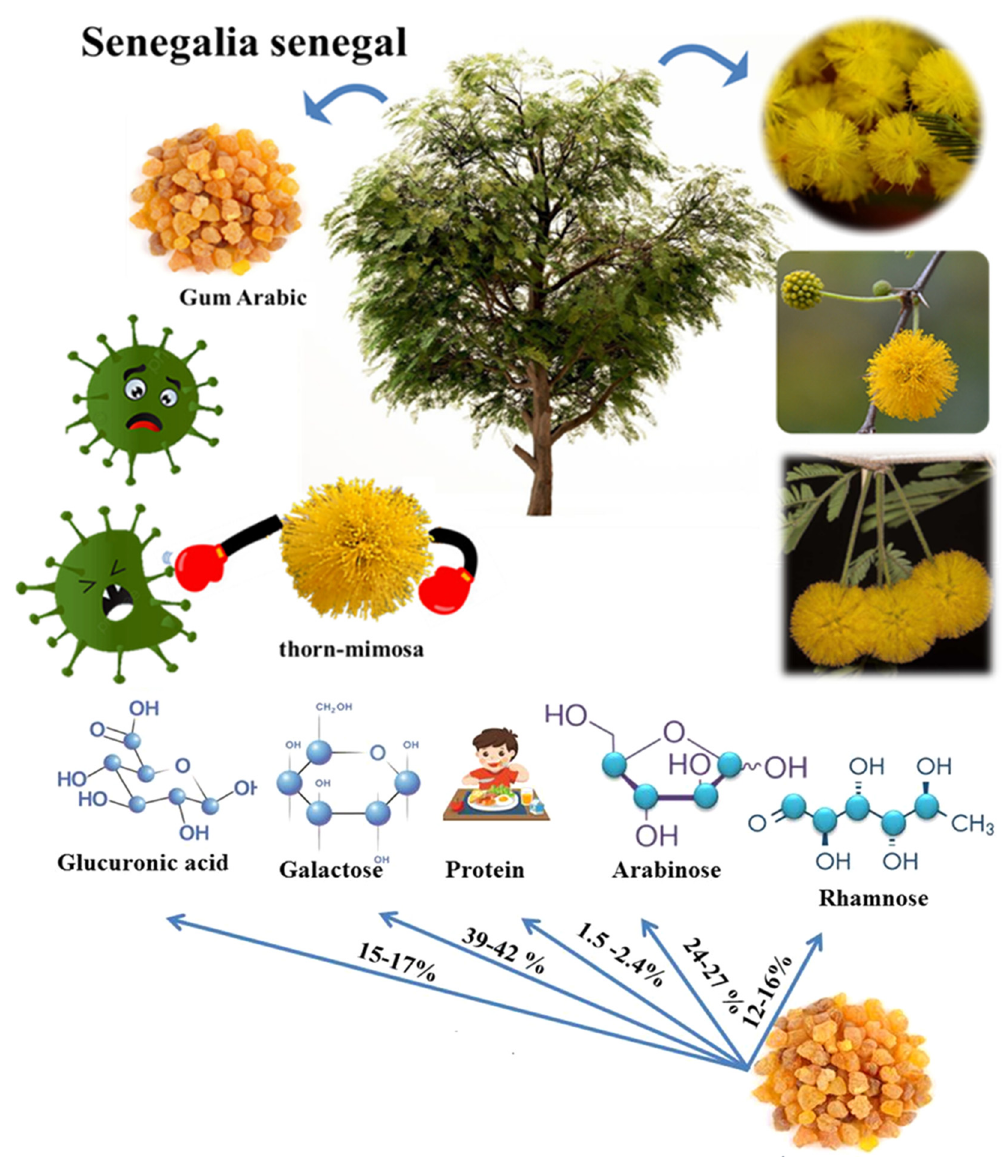
Figure 5: Illustration of the Arabic gum structure and how it can inactivate SARS - CoV -